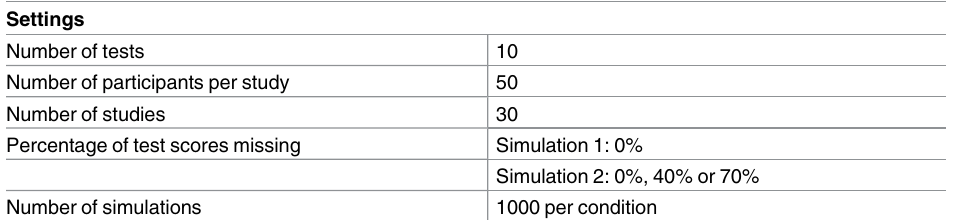
Table 4. Settings used in the two simulation